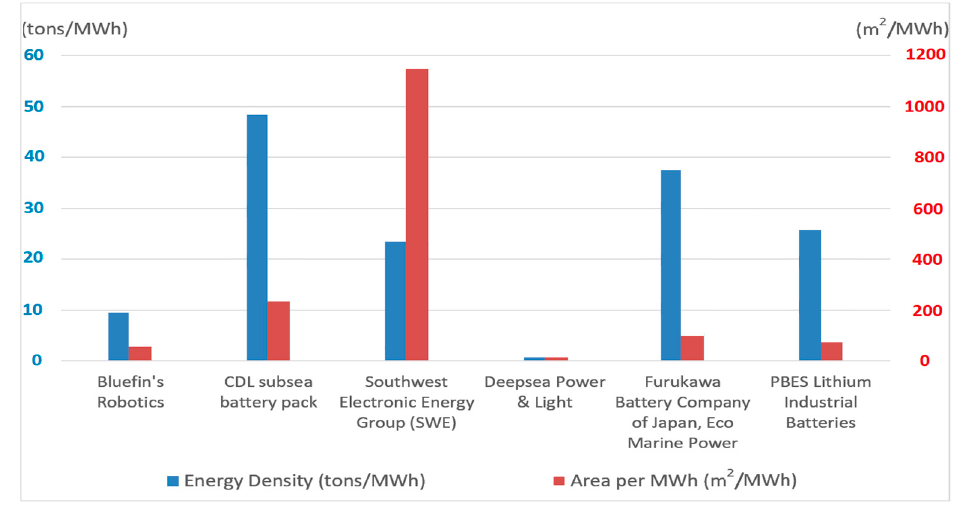
Figure 6. Marine batteries comparison.